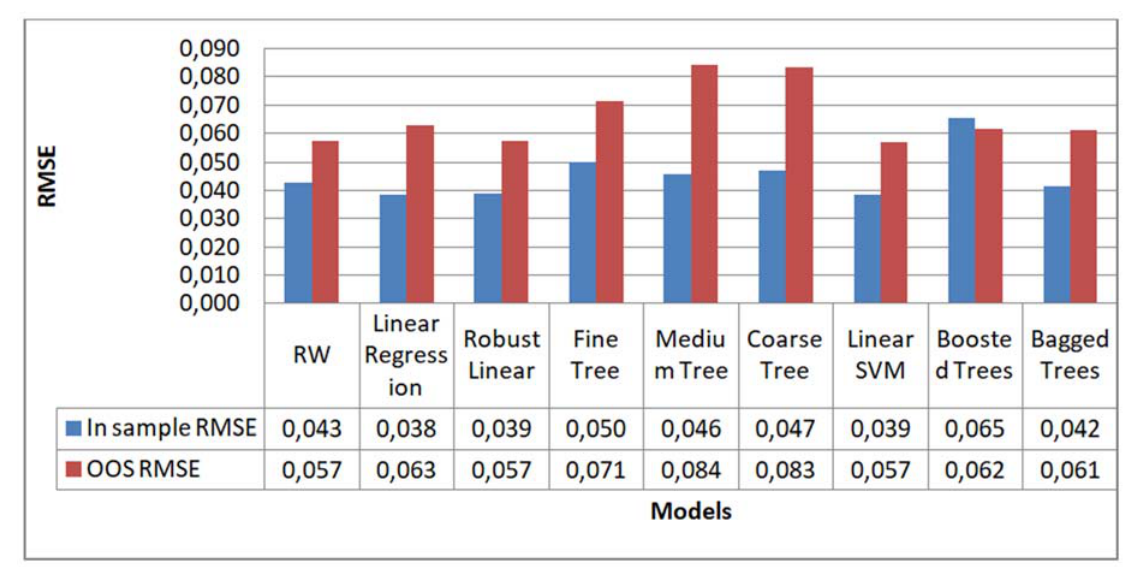
Figure 5. RMSE for t + 1 forecasting.